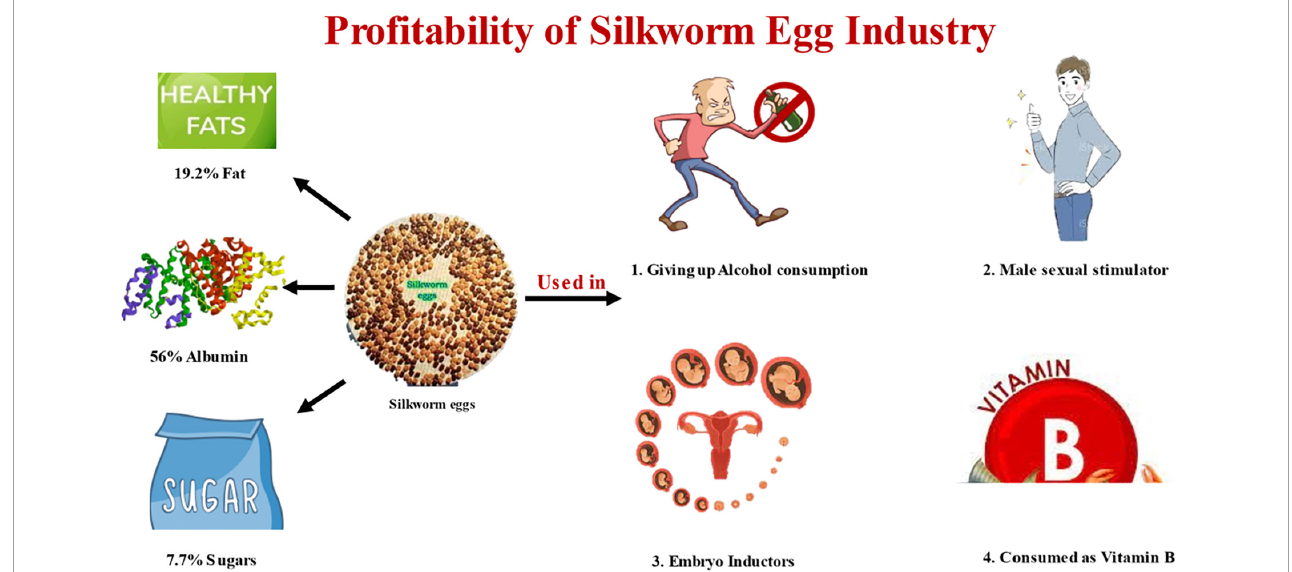
FIGURE1 Representing amount of fat (19.2%), albumin (56%), and sugars (7.7%) in silkworm egg. The figure is also depicting about different functions of silkworm eggs like giving up alcohol consumption, male sexual stimulator, embryo inductor, and source of vitamin B.